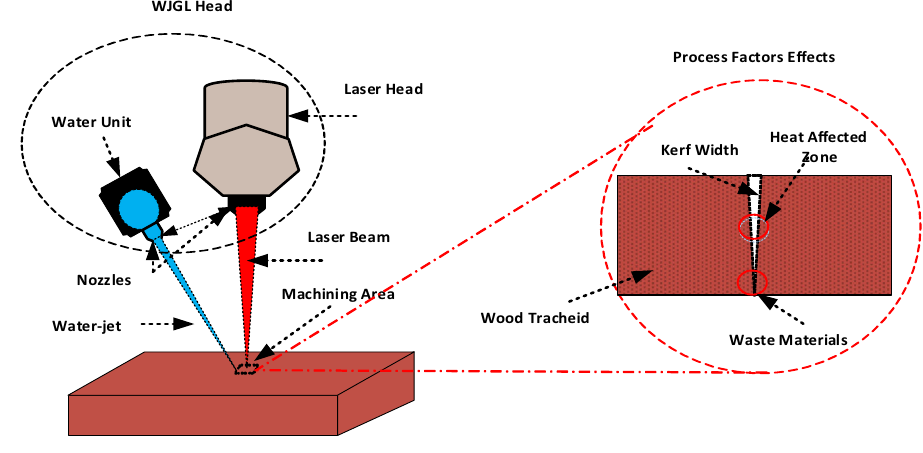
Fig. 2 Schematic illustration of hybrid WJG Nd: YAG laser wood processing mechanism